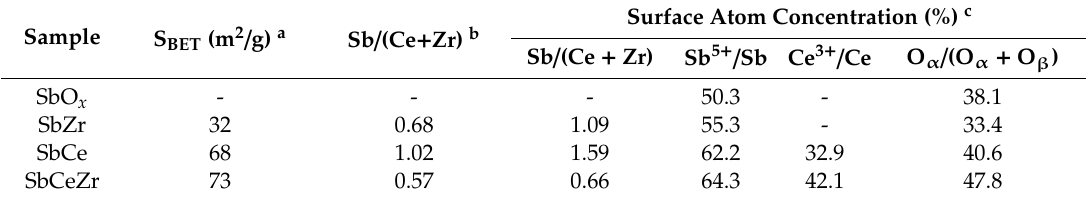
Table 1. Brunauer–Emmett–Teller (BET) specific surface area (SSA), bulk phase, and surface atom